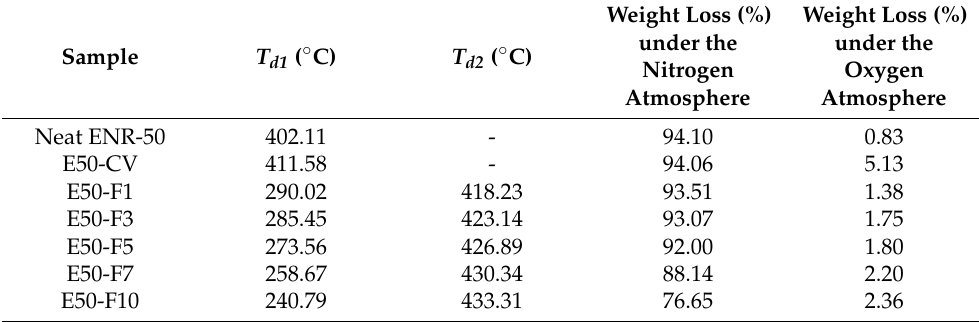
Table 6. Degradation temperature (T d ) of the neat ENR-50 and ENR-50 compounded with various concentrations of FeCl 3 and the conventional sulfur vulcanization (i.e., E50-CV).